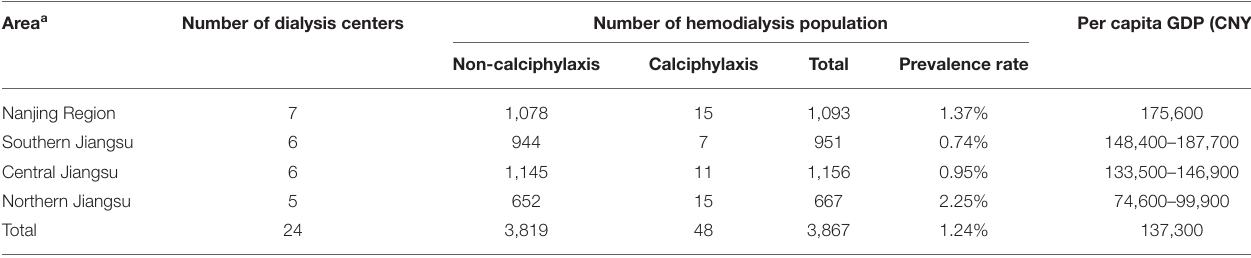
TABLE 1 | Regional distribution of hemodialysis population and prevalence of calciphylaxis.